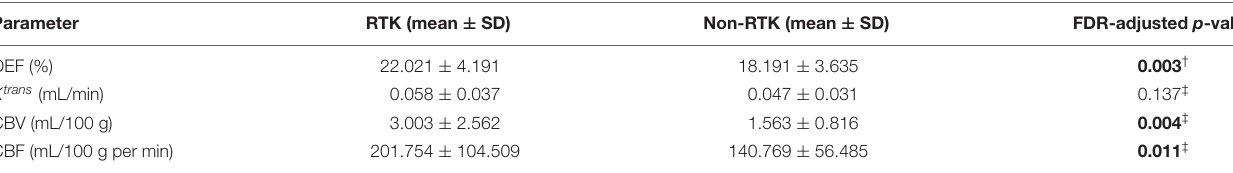
TABLE 4 | Comparison of biomarkers for RTK subgroup.